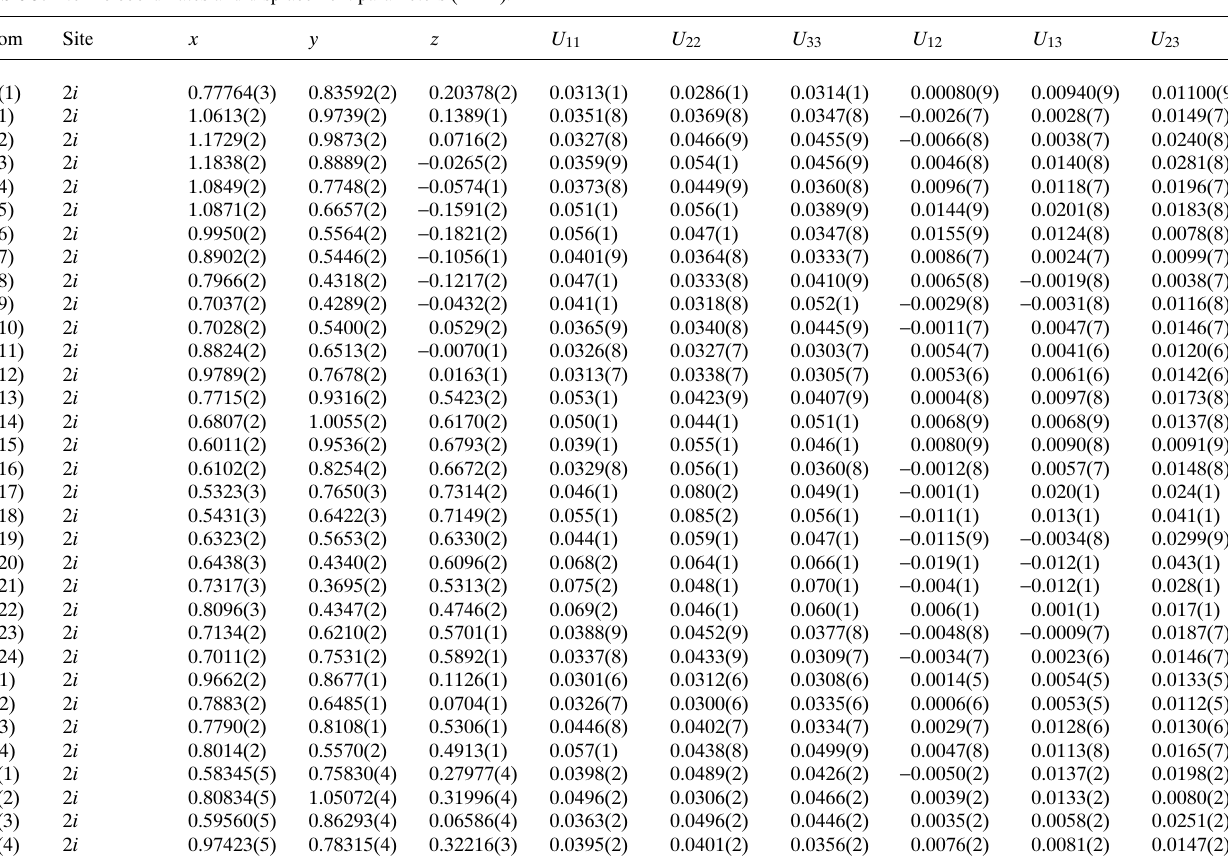
Table 3. Atomic coordinates and displacement parameters (in Å 2 ) .